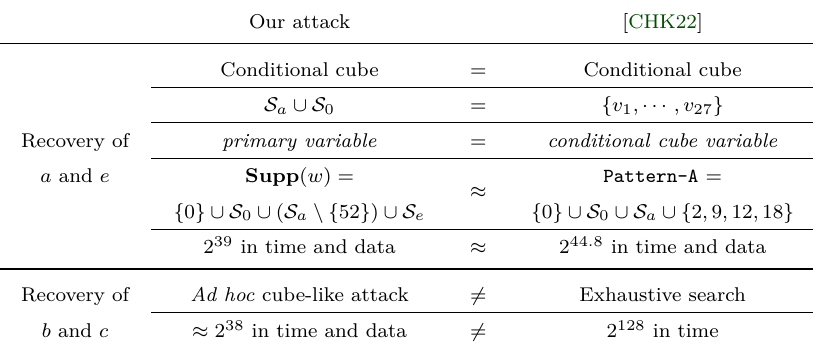
Table 6: Comparative study of our attack with